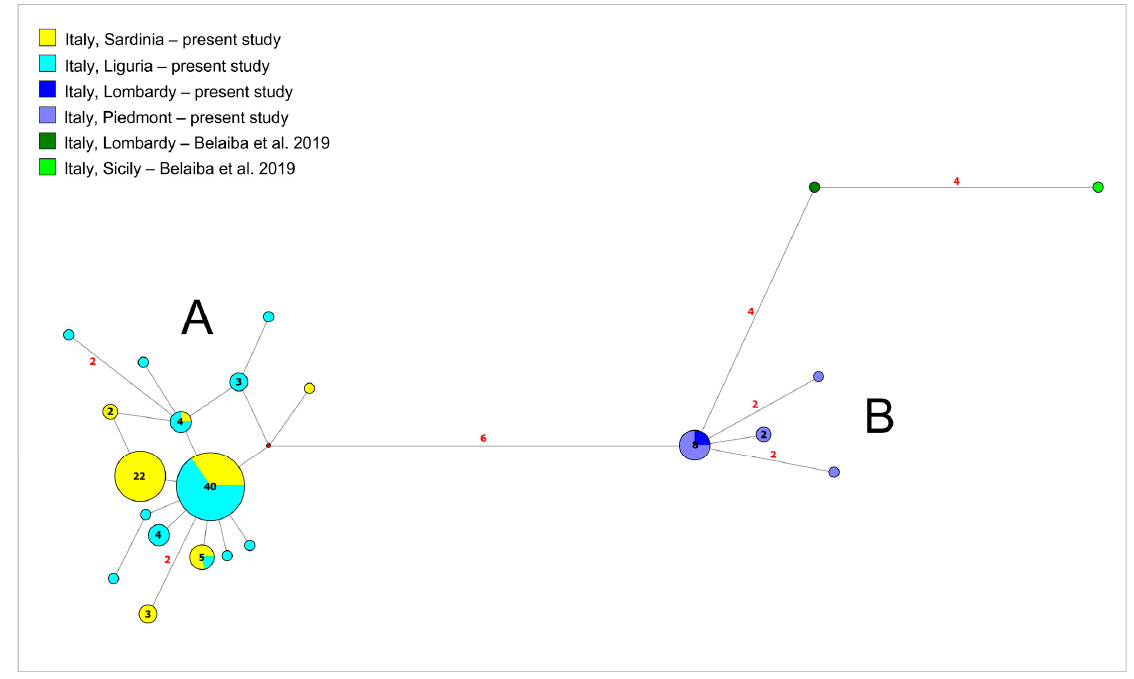
Figure 2. Median-joining network analysis. The network includes all the Italian sequences (from the present study and also from a previous study [15]) for the Control Region and 16s (merged in a concatenated dataset). Clusters A and B are described in the text. The number of mutations between sequences that are greater than n = 1 are reported on network branches. The number of individuals showing the same haplotype that is greater than n = 1 is reported inside the spots. Belaiba et al., 2019 in the legend corresponds to the reference [15].